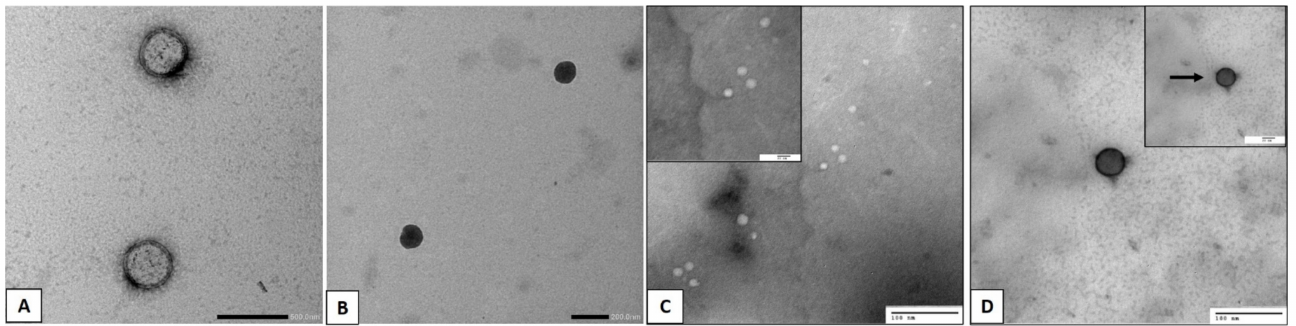
Figure 2. TEM of ( A ) empty Liposomes (206,000 × magnification), ( B ) luteolin-loaded liposomes (183,000 × magnification), ( C ) empty CHS (120,000 × magnification) and ( D ) luteolin-loaded CHS (150,000 × magnification). Arrows point to the chitosan coating